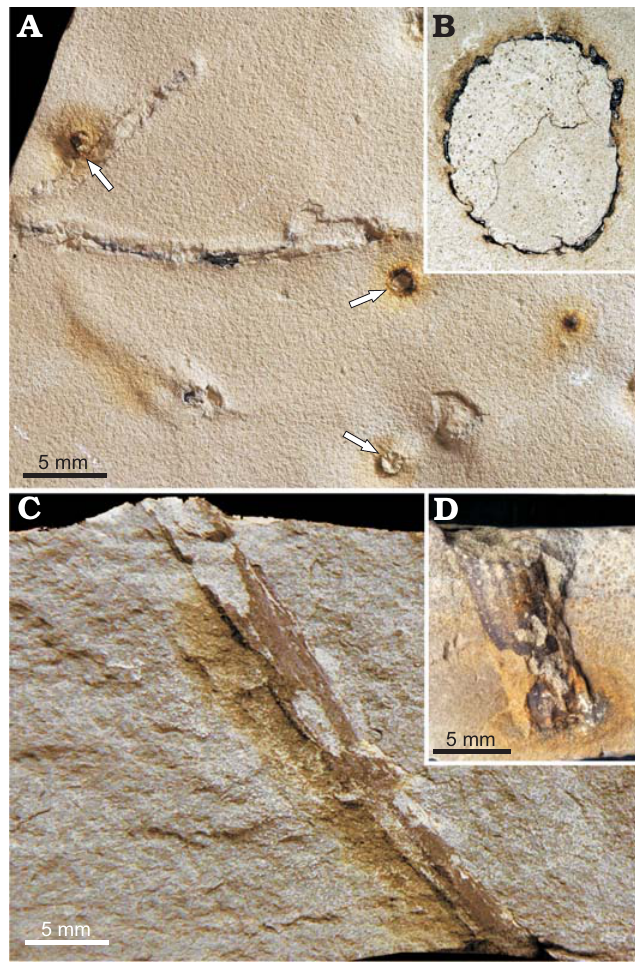
Fig. 4. Lower plant (reed?) stems in siltstone-sandstone slabs from of the middle–late Eocene, Mount Wawel Formation, Martel Inlet Admiralty Bay, King George Island, Antarctica, slab ZPAL Tf.8/2007.20. A . Lower bed- ding-plane view with cross section of the stems (arrows) and needle-like plant detritus shallowly buried in the bed. B . Cross section of the stem in thin section showing sand-filled interior and carbonized, ribbed wall. C . Cross section of the bed with oblique stem, whose surface is carbonized. D . Cross section of a bed showing a fragment of stem with longitudinal